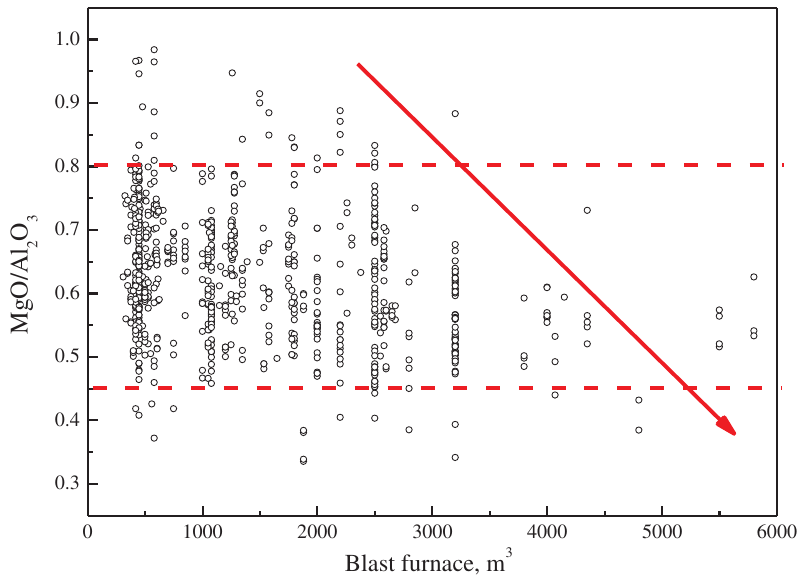
Figure 1: MgO/Al 2 O 3 varies with blast furnace effective volume in